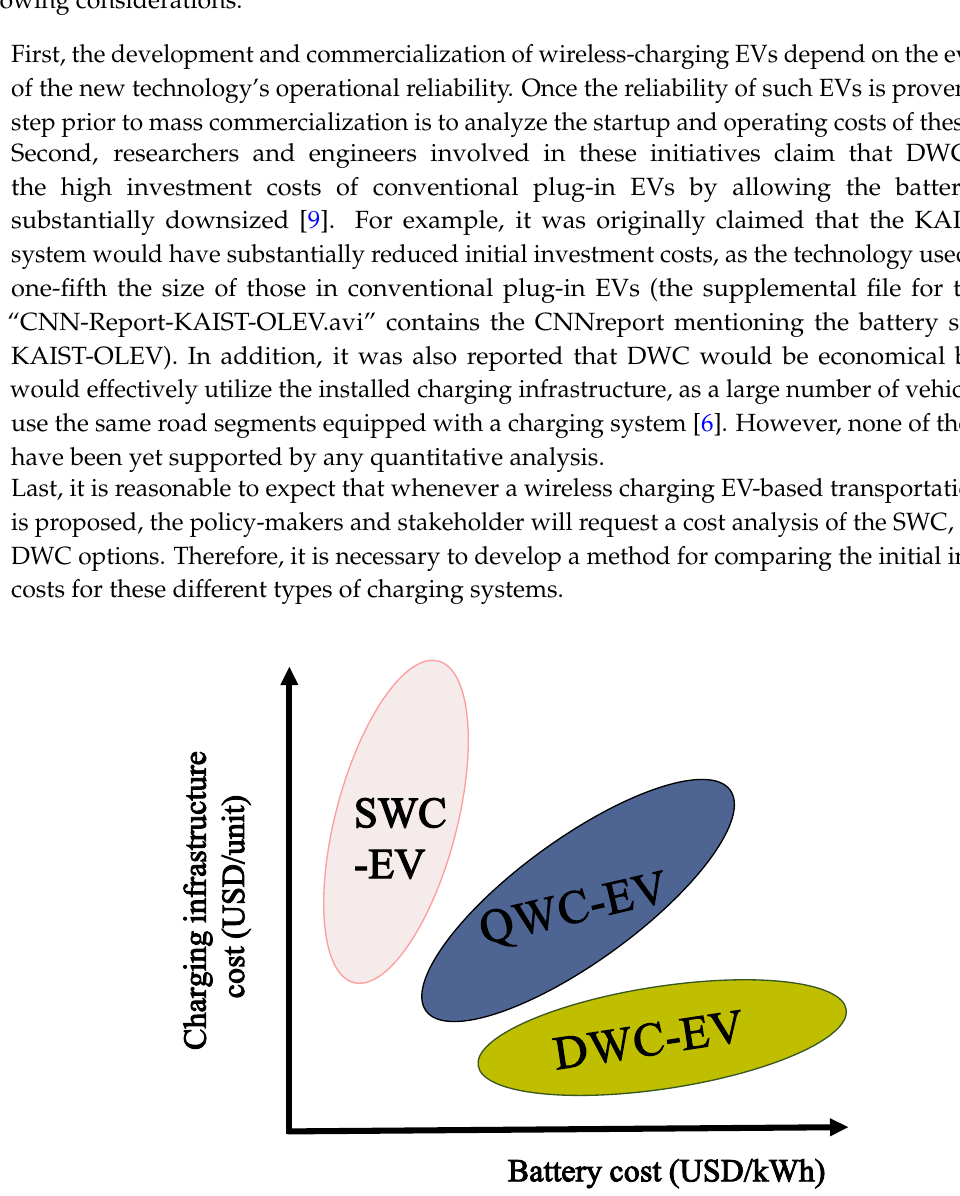
Figure 2. Qualitative analysis of the economic benefits of different EV charging systems